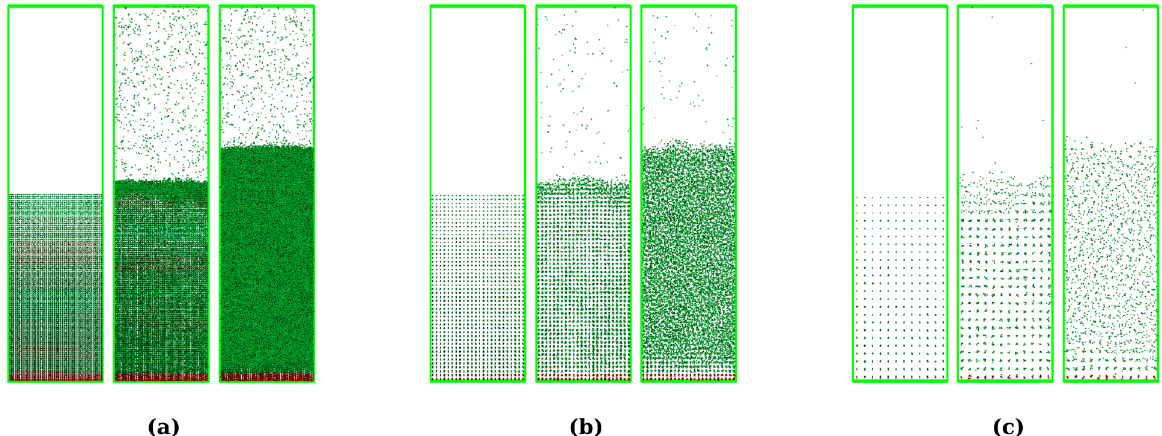
2 0 ). ( b ) The renormalized system =